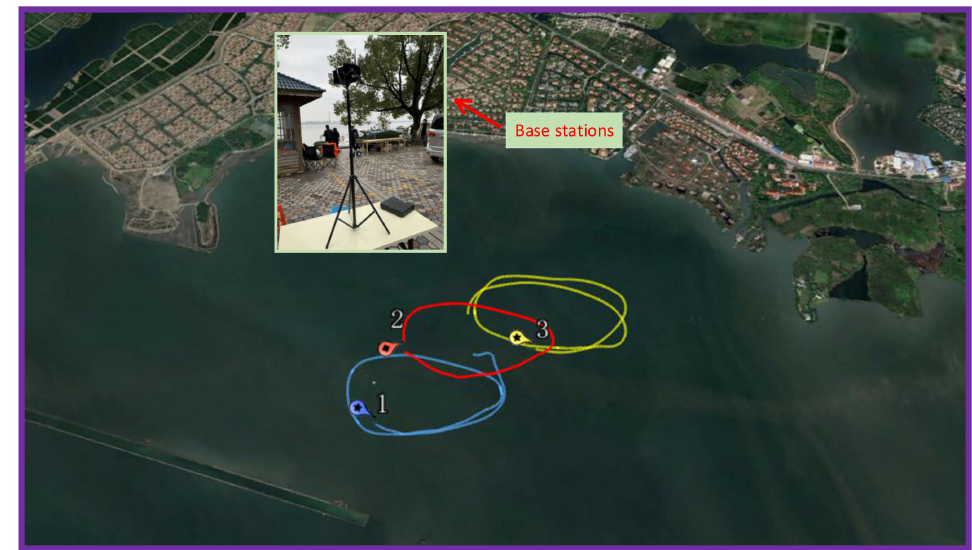
Figure 8. Schematic diagram of the trajectory.